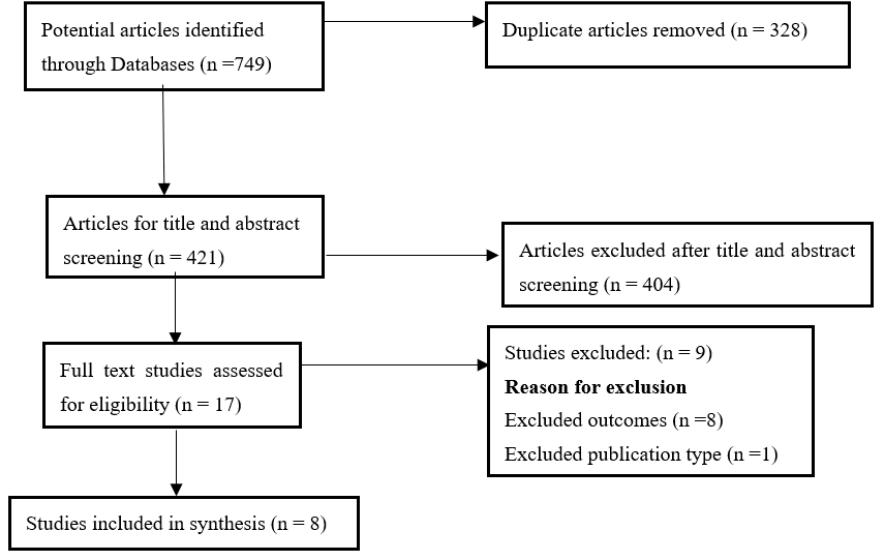
Figure 1. Flow diagram of the scoping review study selection process .